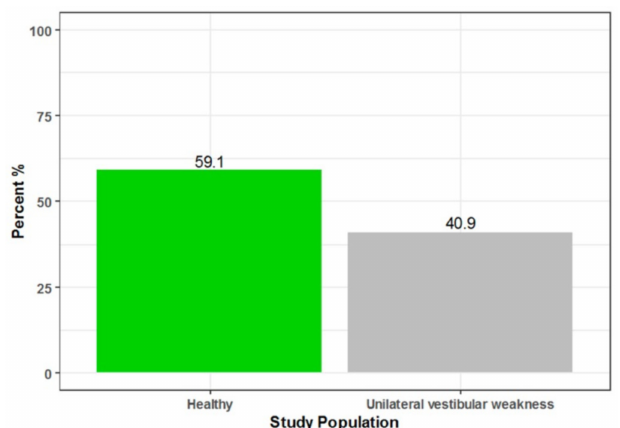
Figure 1. Patient with unilateral vestibular weakness and healthy